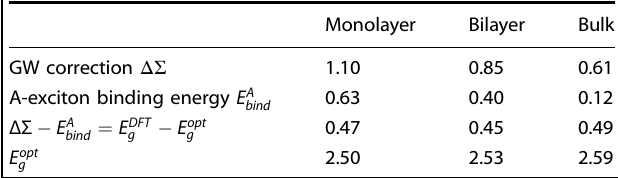
Table 4. Layer-dependent GW band gap correction ( ΔΣ ) (to the direct gap at the K point), binding energy of the A exciton ( E A gap ( E opt ) of MoSi 2 N 4 . (in g